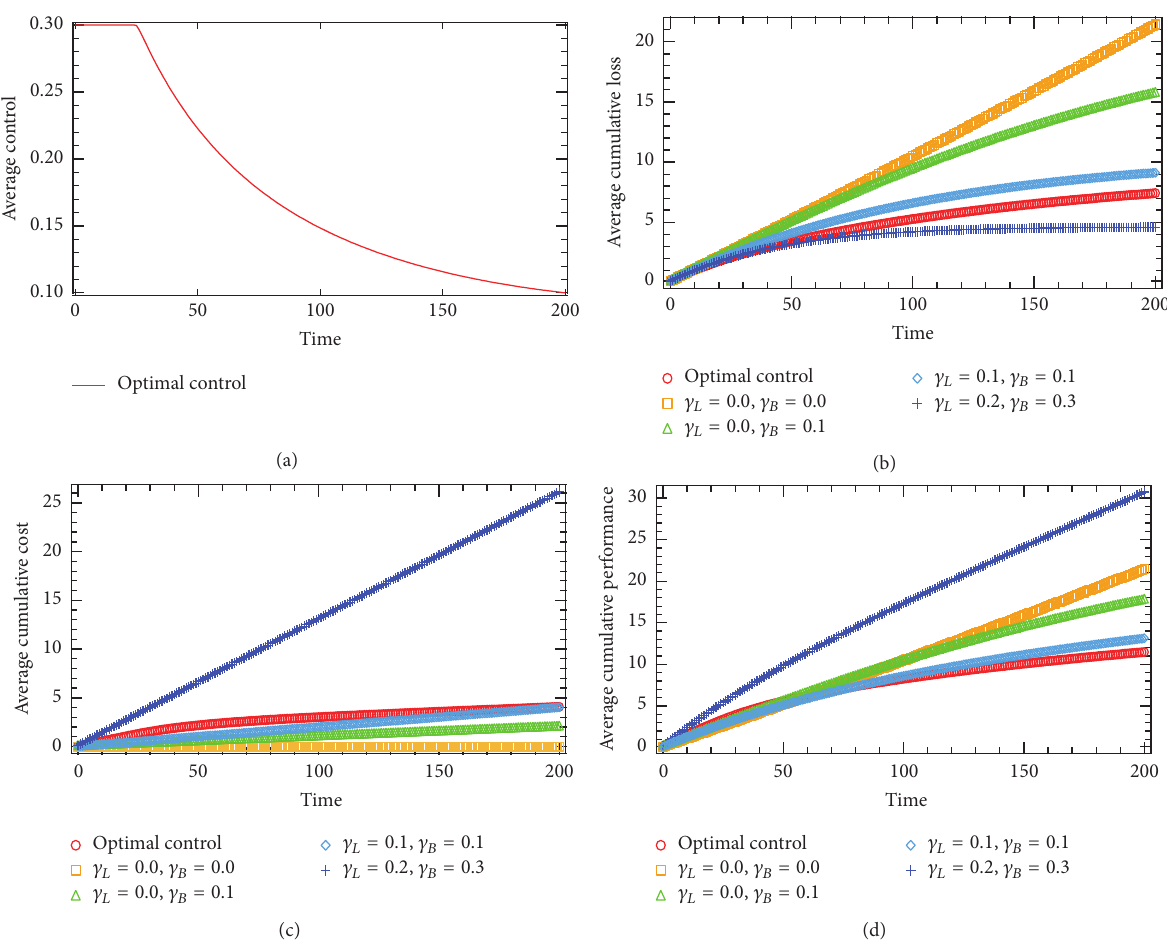
Figure 2: (a) The AC functions, (b) the ACL functions, (c) the ACC functions, and (d) the ACP functions for the optimal dynamic control strategies in Example